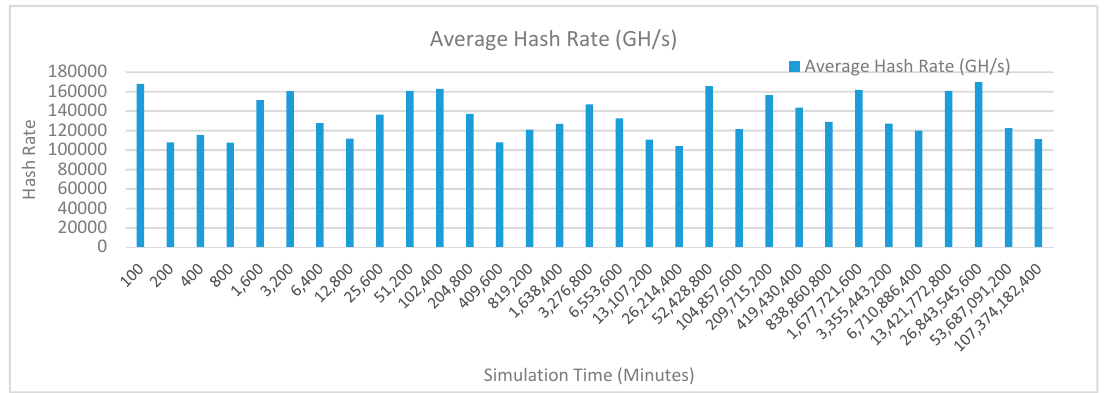
Figure 21. Average hash rate analysis (with IoT and edge).